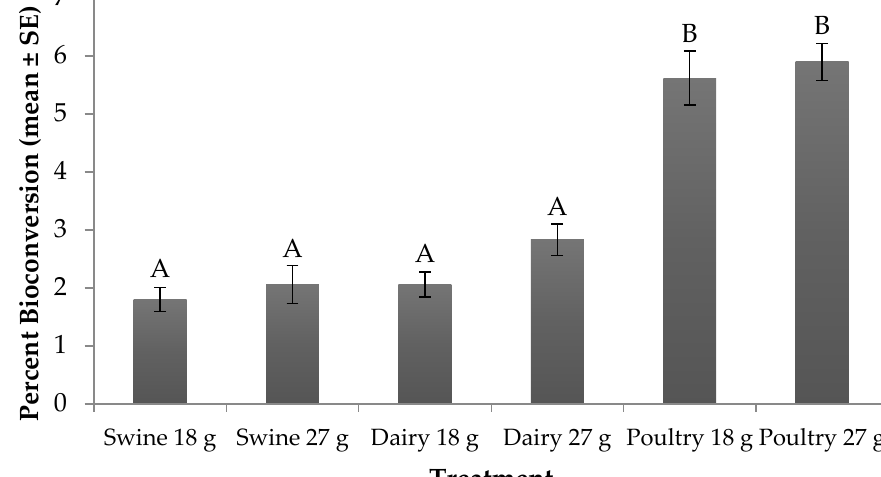
Figure 2. Percent bioconversion (mean ± SE, 1 n = 6) for black soldier fly larvae fed swine, dairy or poultry manure at two feed rates every other day at 29 °C, 60% RH, and 16L:8D. Different letters indicate significant differences between treatments (α = 0.05), ANOVA followed by Tukey’s HSD (honest significant difference). 1 n = number of replicates per treatment.